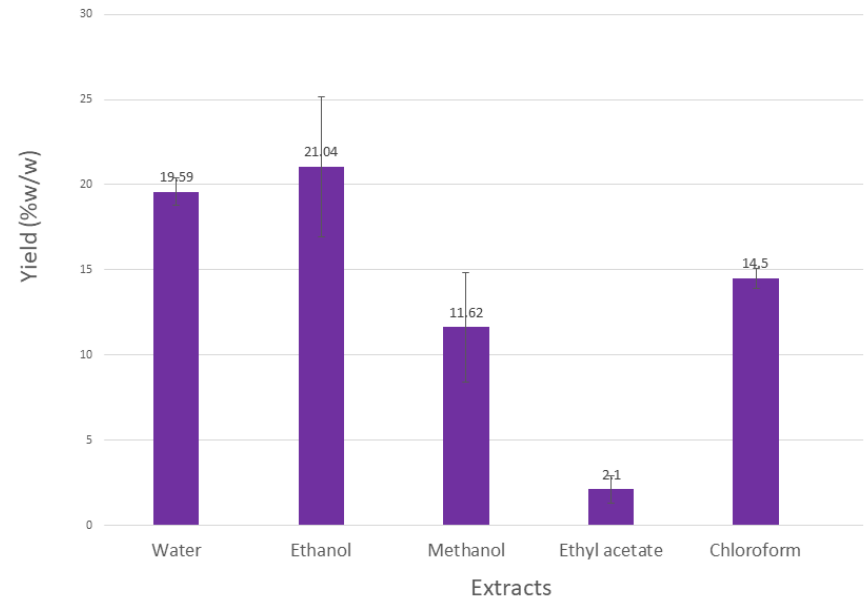
Figure 1. Percentage yields obtained by extraction of 100 g of L. angustifolia .